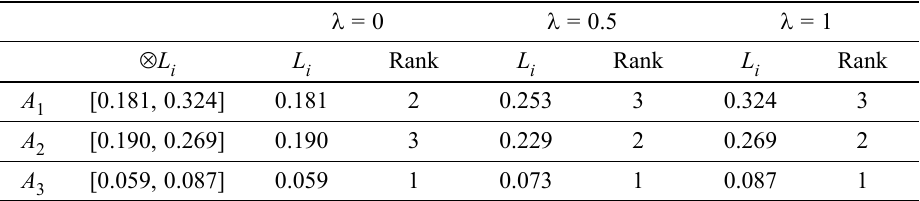
Table 10. Ranking results obtained for p = 1 and characteristic values of λ λ = 0 λ = 0.5 λ = 1 ⊗ L L i i